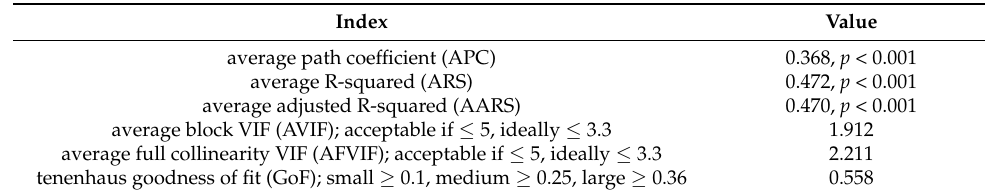
Table 5. Model fit and quality indices.